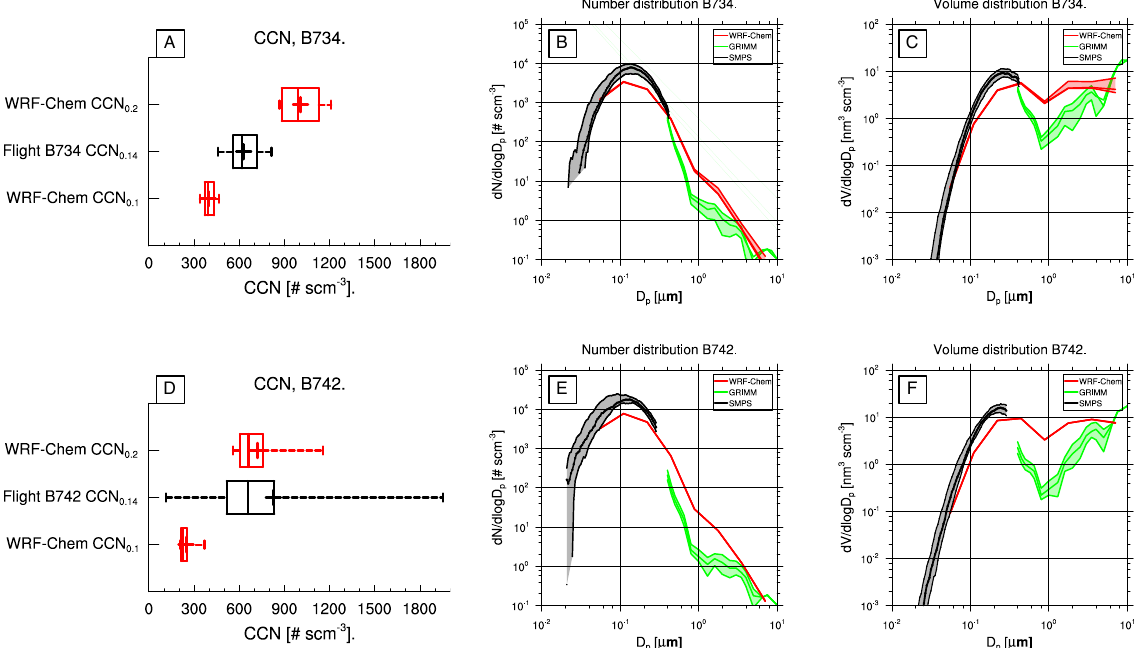
Figure 10. Plots of CCN concentration (scm − 3 ) and size distribution d N/ dlog 10 (D p ) (scm − 3 ). Comparing flight data from flights B734 ( a , b and c ) and B742 ( d , e and f ) with model data from modified emissions run. Model data extracted along flight path and interpolated in vertical axis and in time. CCN plots show CCN concentration at approximately 0 . 14 % supersaturation (CCN 0 . 14 ) from measurements, with CCN concentrations at 0.1 and 0.2% supersaturation (CCN 0 . 1 , CCN 0 . 2 ) from model. Number and volume size distributions show data from WRF-Chem modified emission scenario across the full 8-bin MOSAIC size range (red), the SMPS instrument below 0.3µm (black) and the GRIMM instrument above 0.3µm (green). The central lines show median and the shaded regions show interquartile